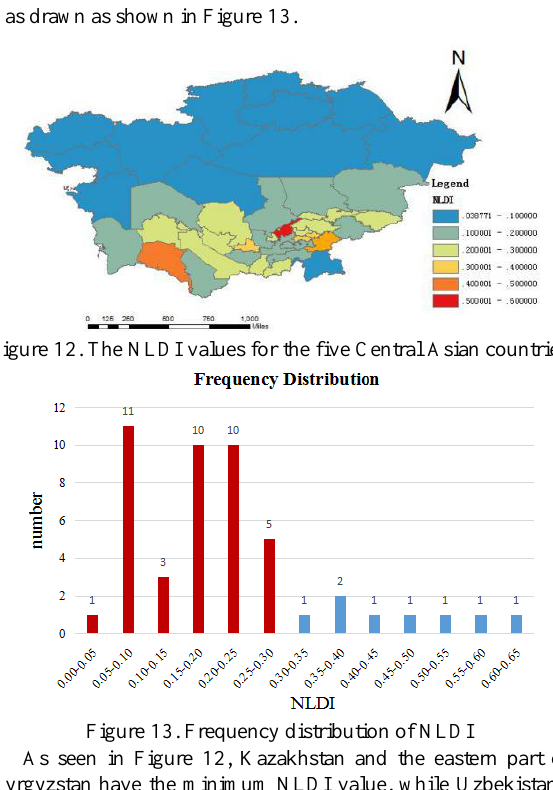
The NLDI values were used to measure regional inequality.